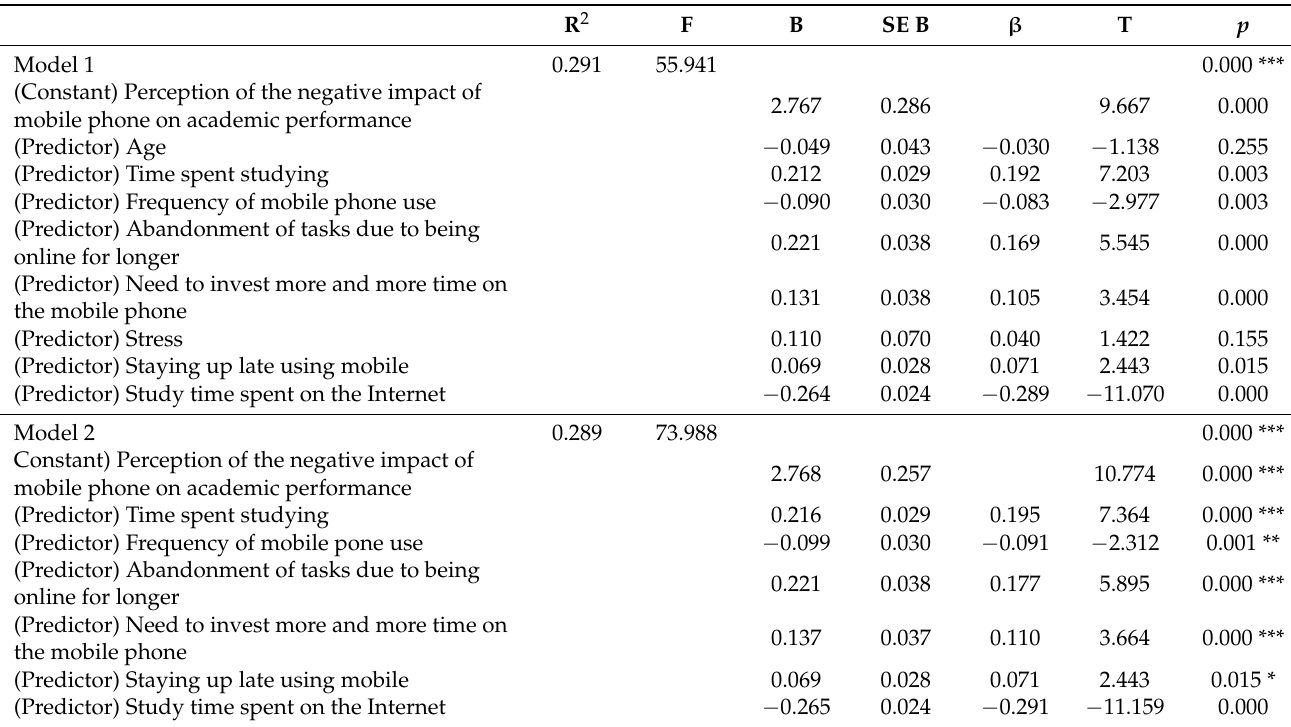
Table 1. Factors that predict the decline in academic performance due to mobile phone use.